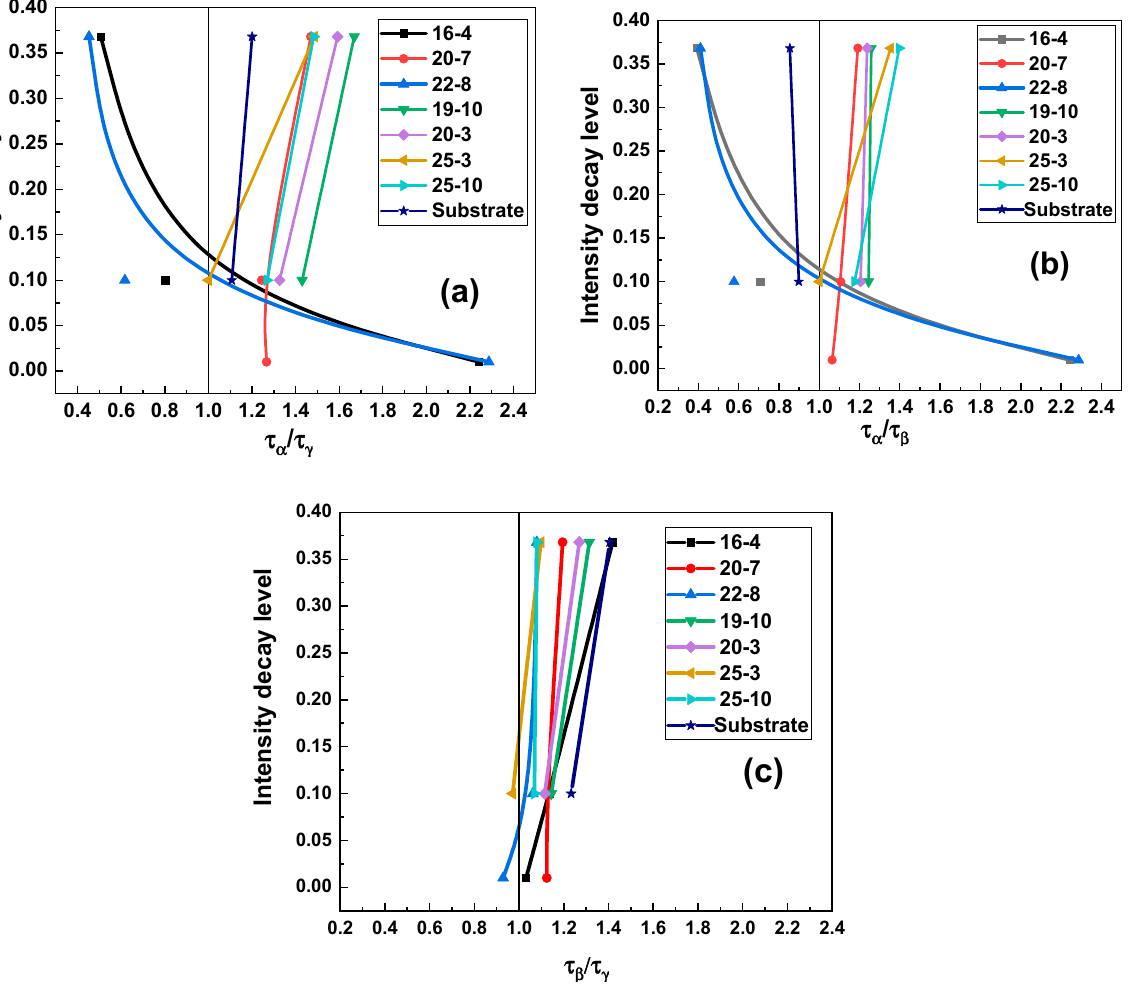
Figure 10. τ α / τ γ ( a ), τ a / τ β ( b ), and τ β / τ γ ( c ) ratios of the selected multicomponent composite scintillators under study (see Table 4 for the sample denotations).